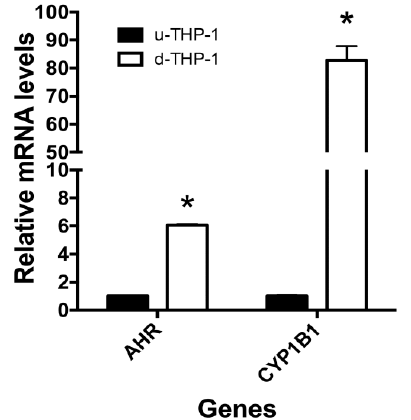
Figure 5. Aryl hydrocarbon (AHR) and CYP1B1 mRNA levels in THP-1 cells. THP-1 cells were differentiated using PMA as described in Materials and Methods. Following treatment, total RNA was isolated and gene expression was determined using RT-PCR. Results are expressed as mean ± SD ( n = 3) relative to undifferentiated control. * indicates significant difference from undifferentiated control at p ≤ 0.05.